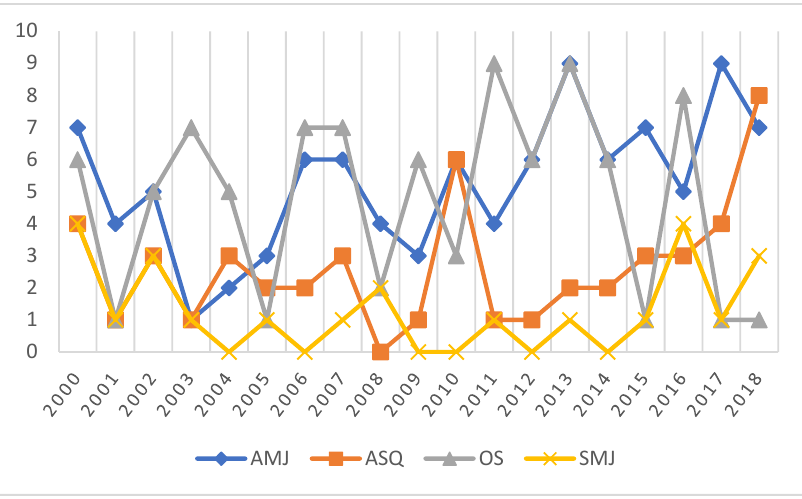
Figure 1. Number of articles that cite Glaser and Strauss